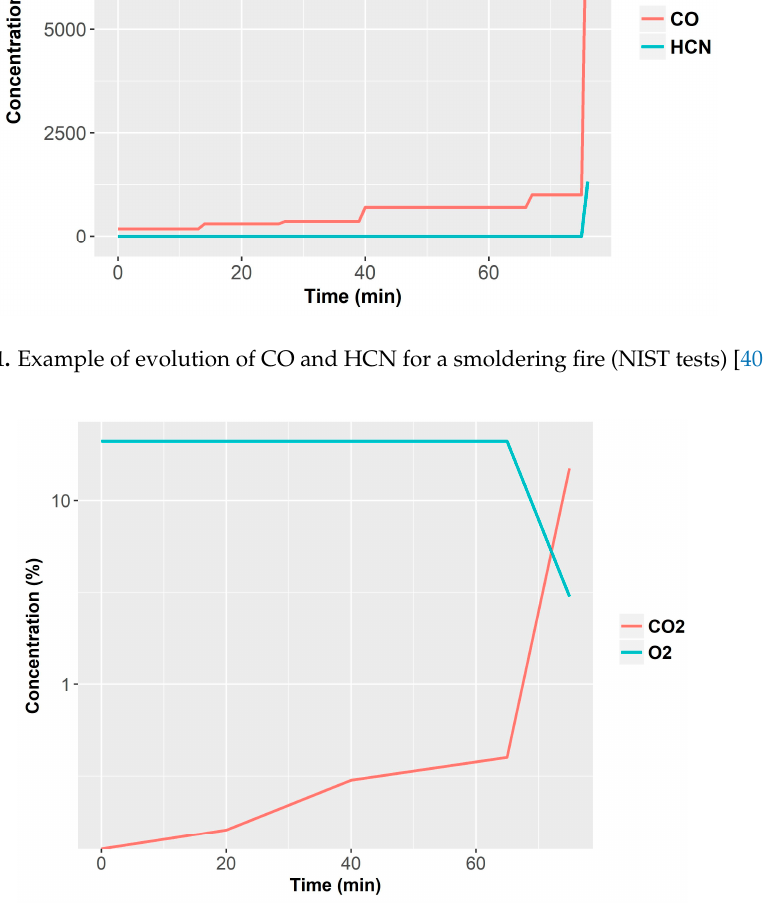
Figure 2. Example of the time evolution of O 2 and CO 2 during a smoldering fire [40].